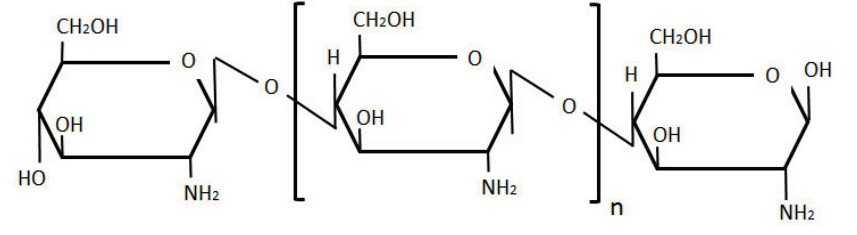
Figure 7. Chitosan structure, composed of deacetylated β -(1-4)-linked D -glucosamine units and of acetylated N -acetyl- D -glucosamine